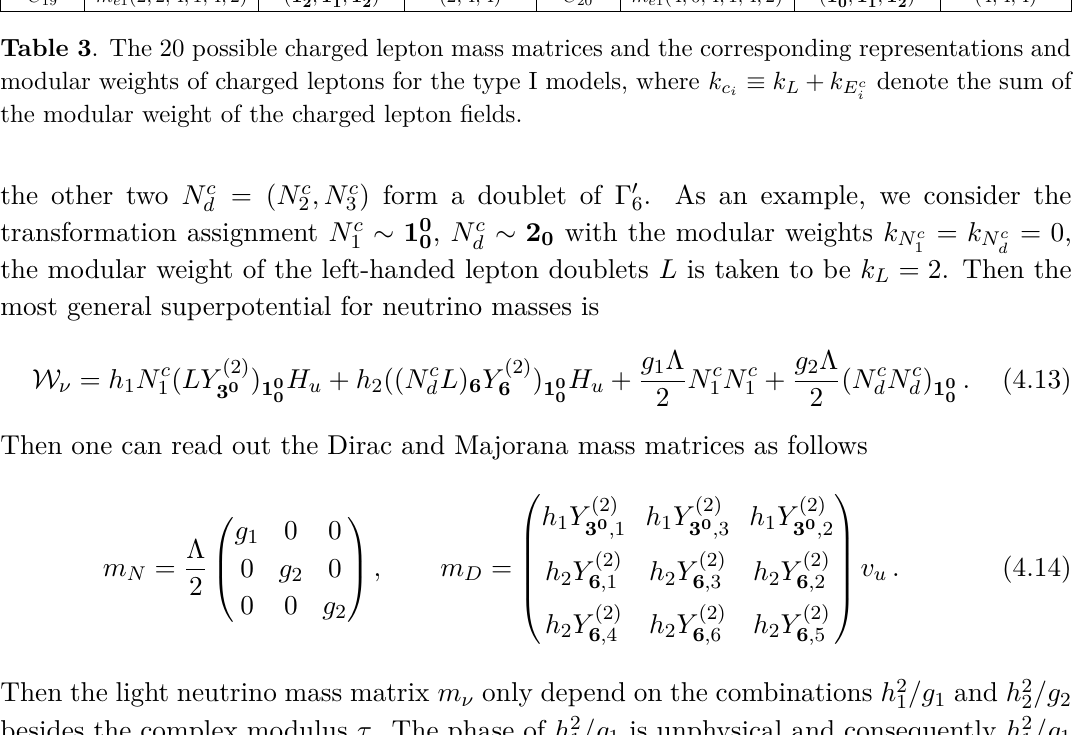
≡ k L + k E c denote the sum of i i